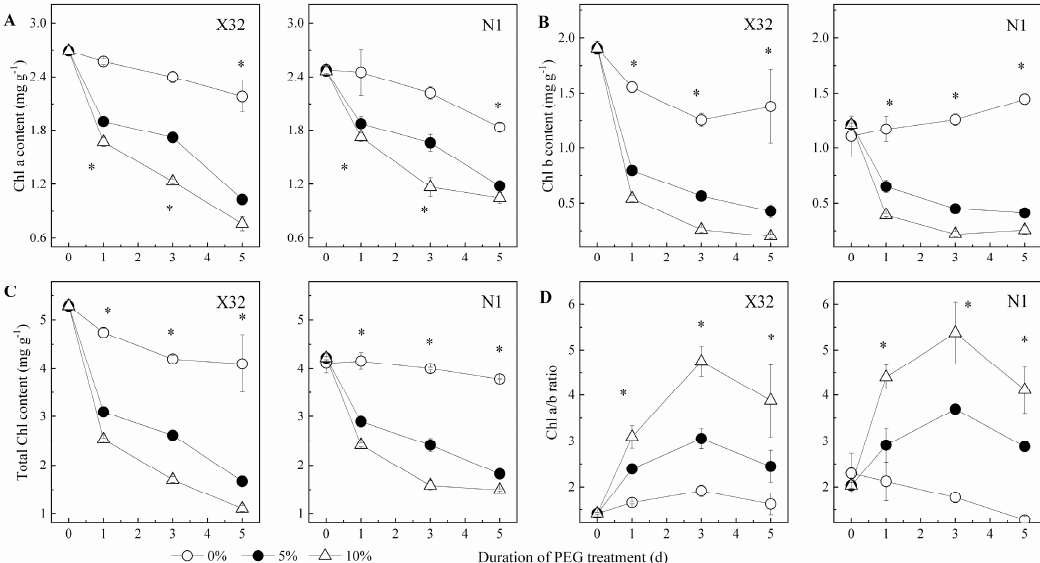
Figure 5. E ff ects of drought stress on chlorophyll content ( A : Chl a content; B : Chl b content; C : Total Figure 5. Effects of drought stress on chlorophyll content (A: Chl a content; B: Chl b content; C: Total Chl content; D : Chl a / b ratio) in sweet potato leaves. X32 and N1 represent Xushu 32 and Ningzishu 1, Chl content; D: Chl a/b ratio) in sweet potato leaves. X32 and N1 represent Xushu 32 and Ningzishu respectively. The stages labeled with an asterisk (*) indicate significant di ff erences ( p < 0.05) among the 1, respectively. The stages labeled with an asterisk (*) indicate significant differences ( p < 0.05) among three PEG levels in the the three PEG levels in the figure.